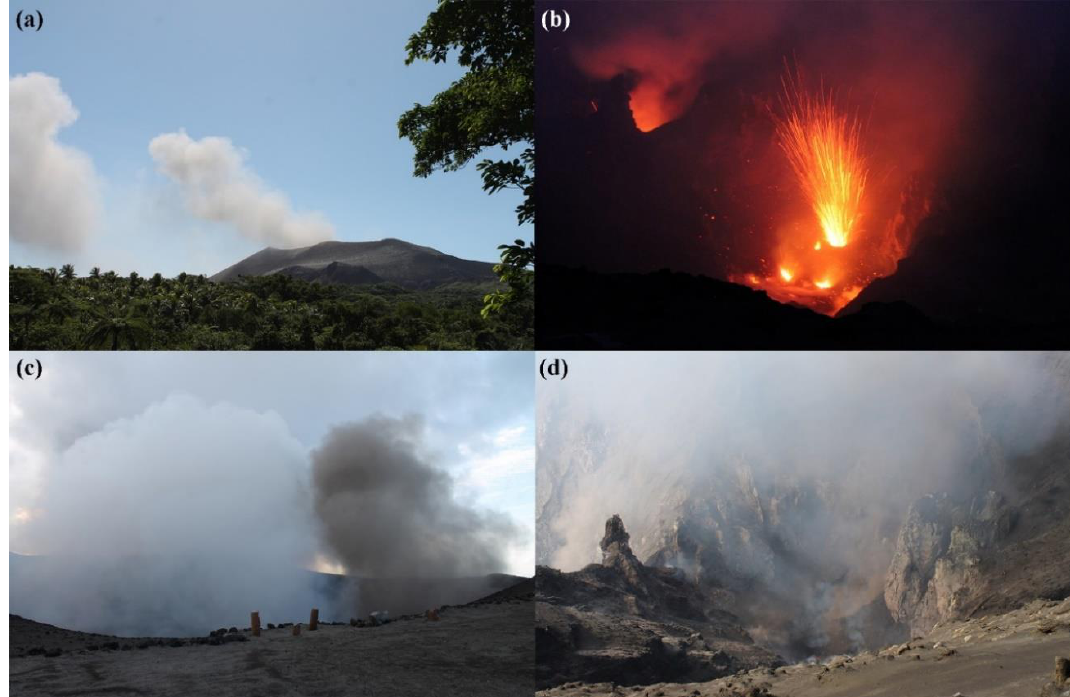
Figure 1. Activity at Yasur volcano, Vanuatu, during the July 2018 field campaign. ( a ) Image of the gas plume rising from the summit crater. Large gas pulses are associated with explosions. ( b ) A nighttime view, with the south crater in the foreground and incandescence from the north crater in the background. Several vents are visible in the south crater, with one producing a Strombolian explosion. ( c ) Ash-rich gas plumes formed by Strombolian explosions occurred from the north crater and ash-poor gas plumes from explosions from the south crater. ( d ) A daytime view into the north crater, showing the crater floor topography divided by a septum into northern and southern craters.